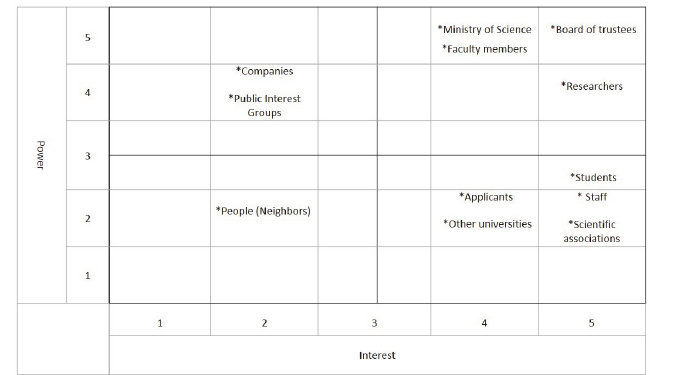
Fig. 3. Positioning of university stakeholders on the power-interest